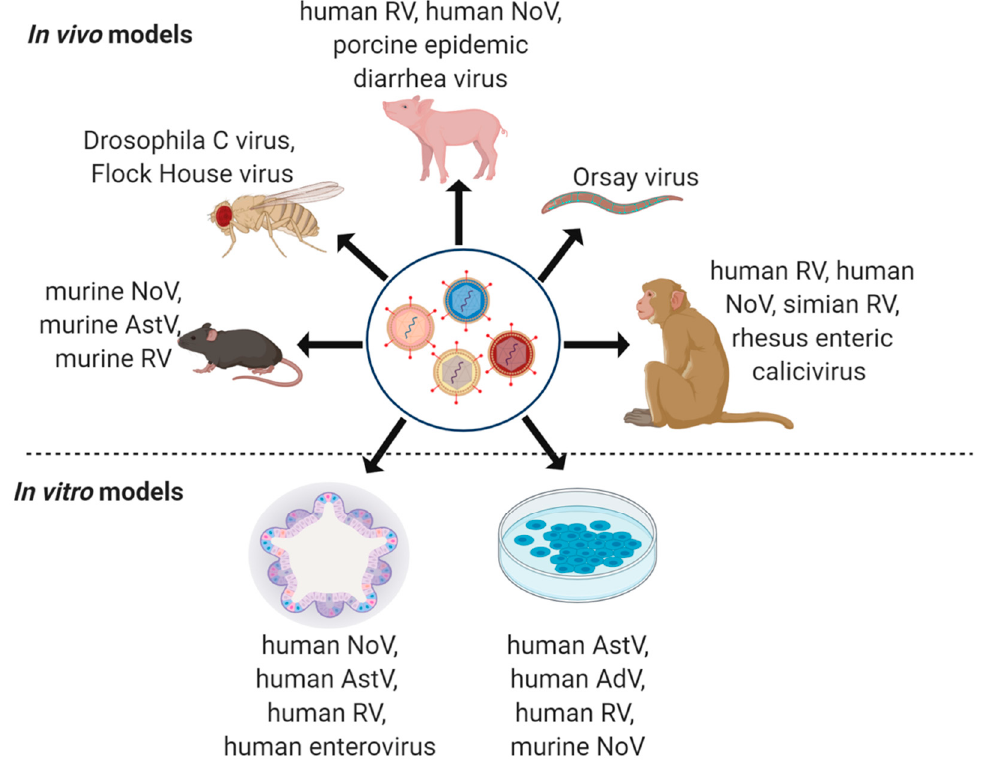
Figure 2. In vivo and in vitro co-infection study models . In vivo models for enteric virus studies include mouse (murine NoV, AstV, and RV), fly (Drosophila C virus, Flock House virus), pig (human RV, human NoV, and porcine epidemic diarrhea virus), C. elegans (Orsay virus) and non-human primate (human RV and NoV, simian RV, and rhesus enteric caliciviruses) models with physiological experimental read-outs. In vitro models that could be used for enteric co-infection studies include organoids/enteroids and immortalized cell lines for detailed analyses in simplified systems. Illustration created using BioRender (BioRender.com).